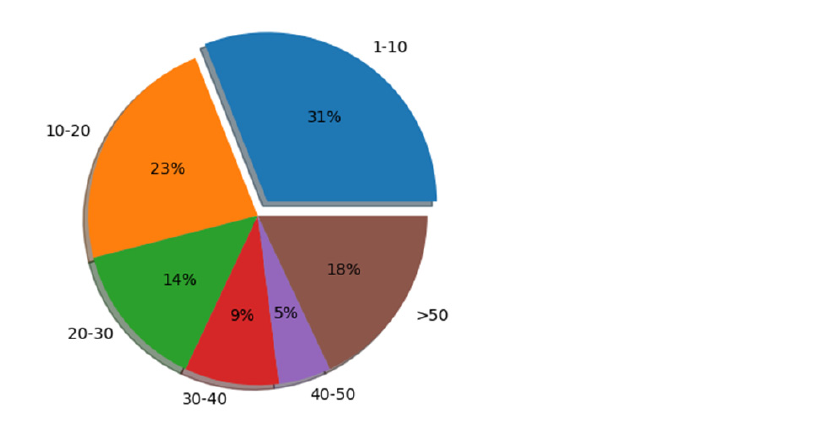
Figure 3. The changes in the number of samples corresponding to different text lengths.